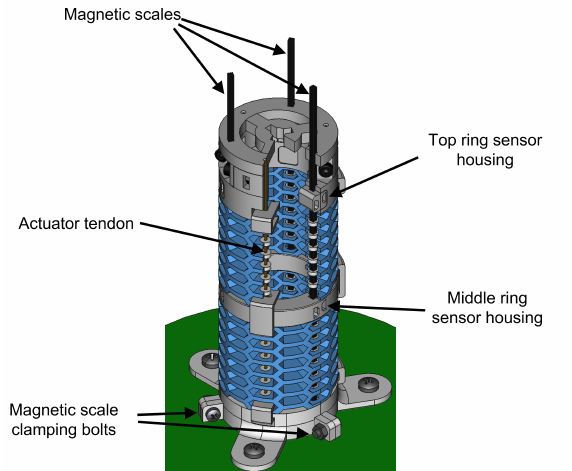
Figure 11. Cutaway view of the soft continuum robot